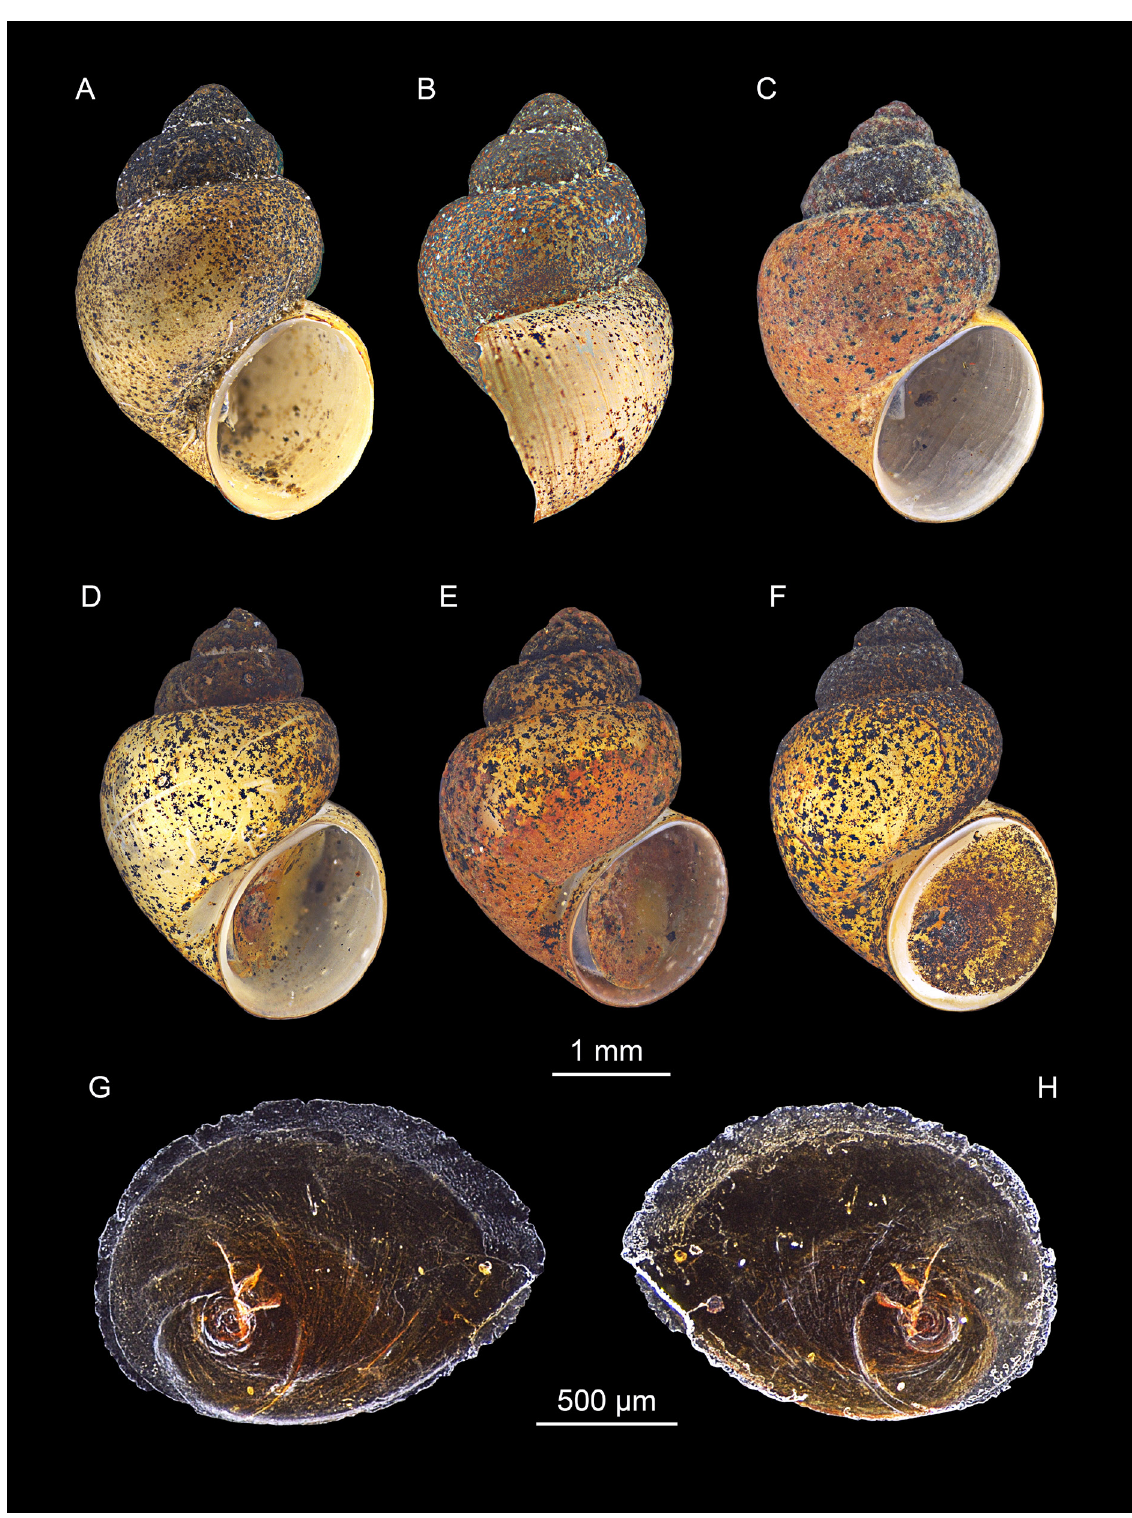
Fig. 23. Shells and operculum of Mercuria felixi Miller, García-Guerrero & Ramos sp. nov. from the stream in Camuto de la Tala, Cádiz, Spain. A – B . Holotype (MNCN 15.05/200176H), frontal and lateral views. C–H . Paratypes (MNCN 15.05/94754). G . Operculum, inner side. H . Operculum, outer